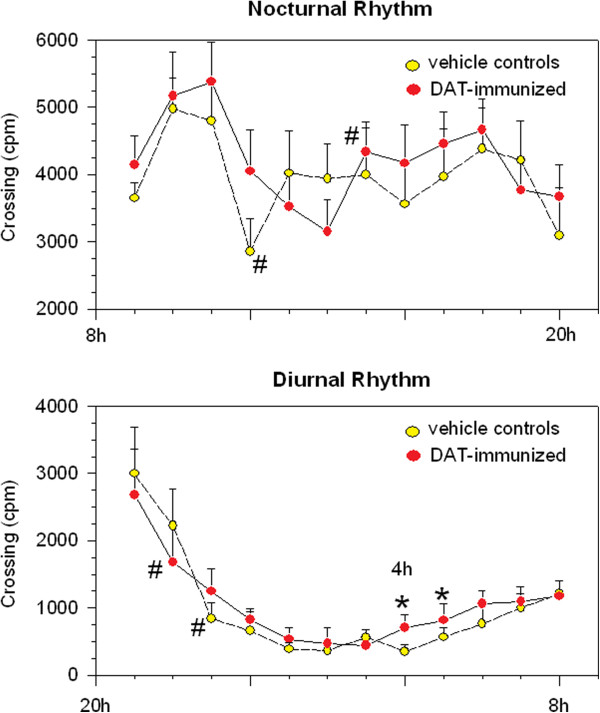
Circadian Rhythm of Spontaneous Activity. Mean (±SEM, n = 6 pairs) counts per minute (cpm) by undisturbed mice, housed in pairs per home cage (sensor rate 20 Hz). Nocturnal (upper panel) and diurnal (lower panel) activity was recorded for 3 days (PND 51–53), five days after the boost with DAT fragment (DAT-i) or VEH. The 24-h profile of one-hour points was then obtained by averaging the 3 days of continuous registration. * p < 0.05 between DAT-i and VEH control group; # p < 0.05, compared to the previous or the following 1-h point within the same immunization group.